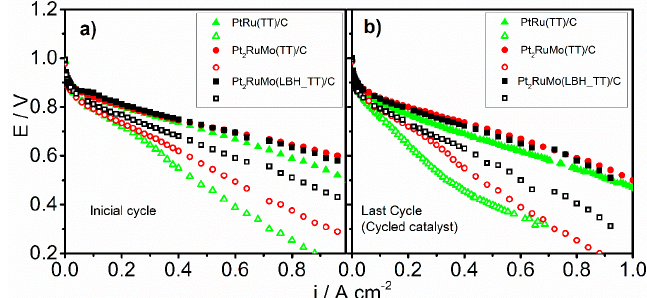
Figure 4. Histogram of the amount of Pt(0), Ru(0) and Mo(0) in Pt 2 RuMo(TT)/C and Pt 2 RuMo(LBH_TT)/C catalysts by XPS measurements.